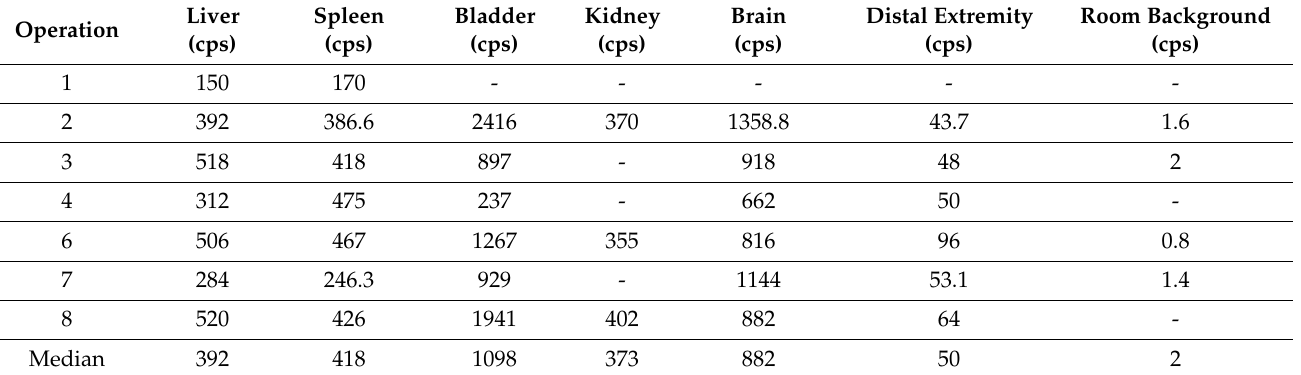
Table 3. PET probe intra-operative external survey. External PET probe survey of metabolically active solid organs, distal extremity, and room